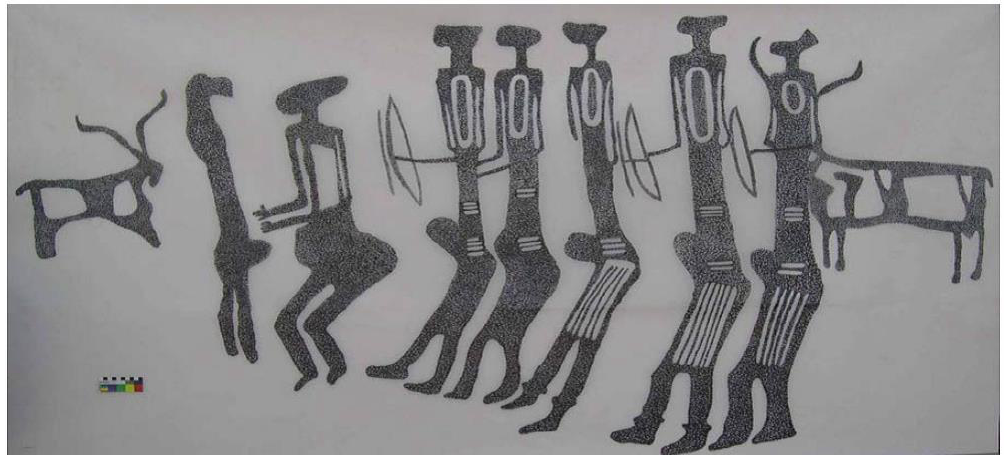
Figure 4. Tracing of a panel. Anthropomorphous representations, probably in dancing attitude, Jubbah,_Northern Arabia.